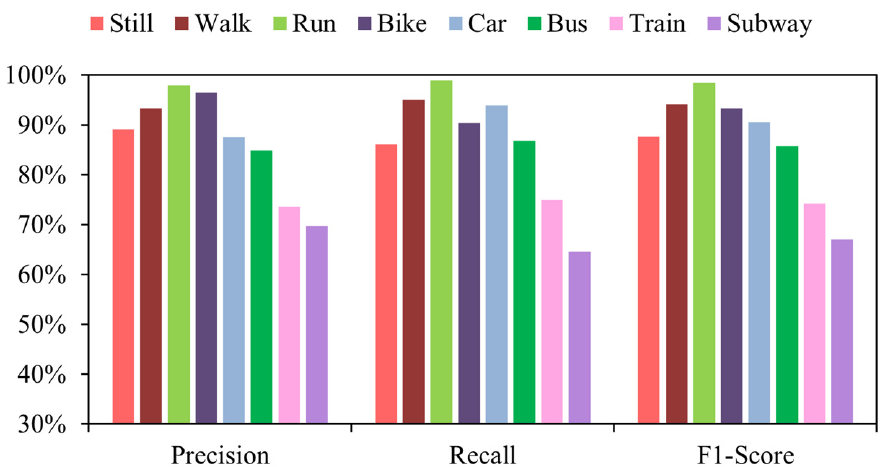
Figure 10. Precision, recall, and F1-scores of the eight classifications of the T2Trans model on the SHL dataset.